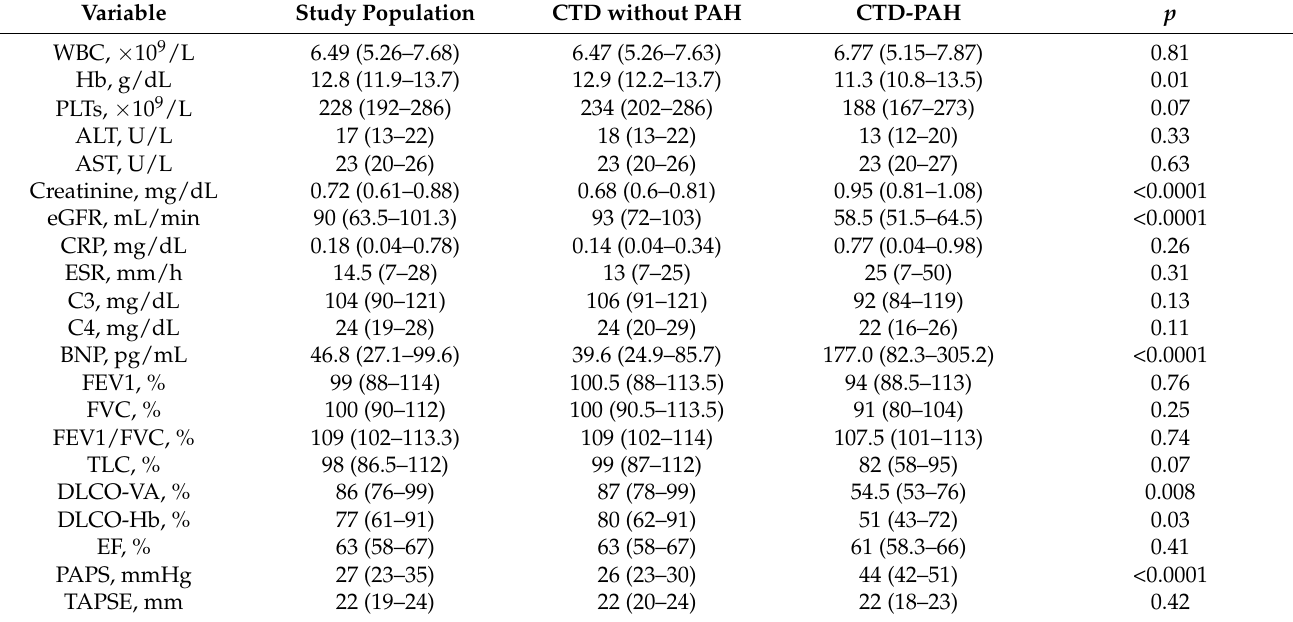
Table 2. Laboratory and instrumental data in the entire study population and in two subgroups categorized according to the presence/absence of pulmonary arterial hypertension. Abbreviations: CTD—connective tissue diseases; PAH—pulmonary arterial hypertension; WBC—white blood cells; Hb—hemoglobin—PLTs—platelets; ALT—alanine aminotransferase; AST— aspartate aminotransferase; eGFR—estimated glomerular filtration rate; CRP—C-reactive protein;